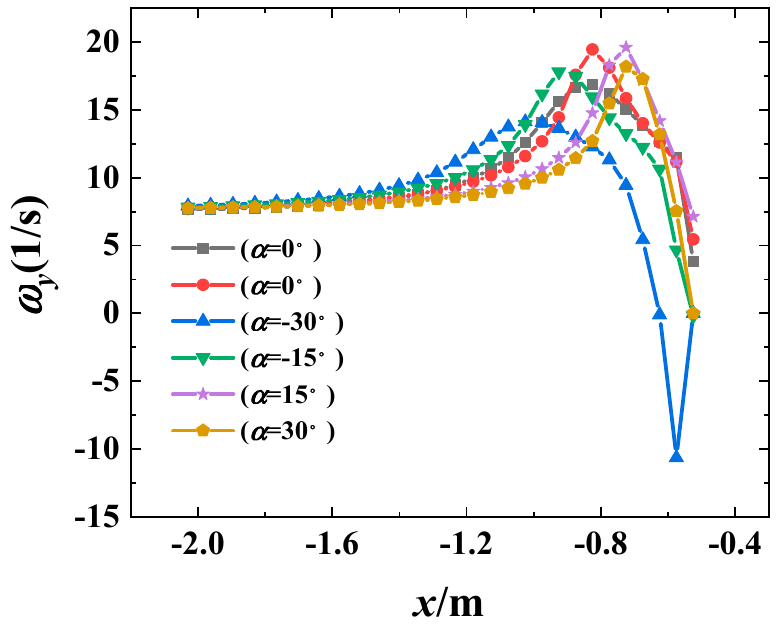
Figure 12. The distribution of the vorticity in front of the cylinder.